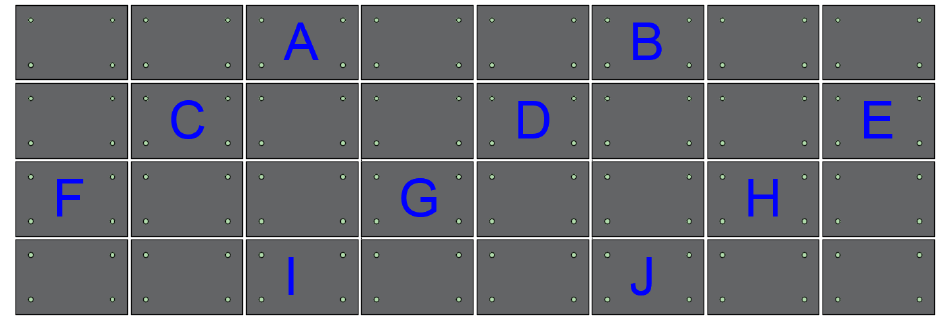
Figure 16. Layout map of the regional monitoring points.